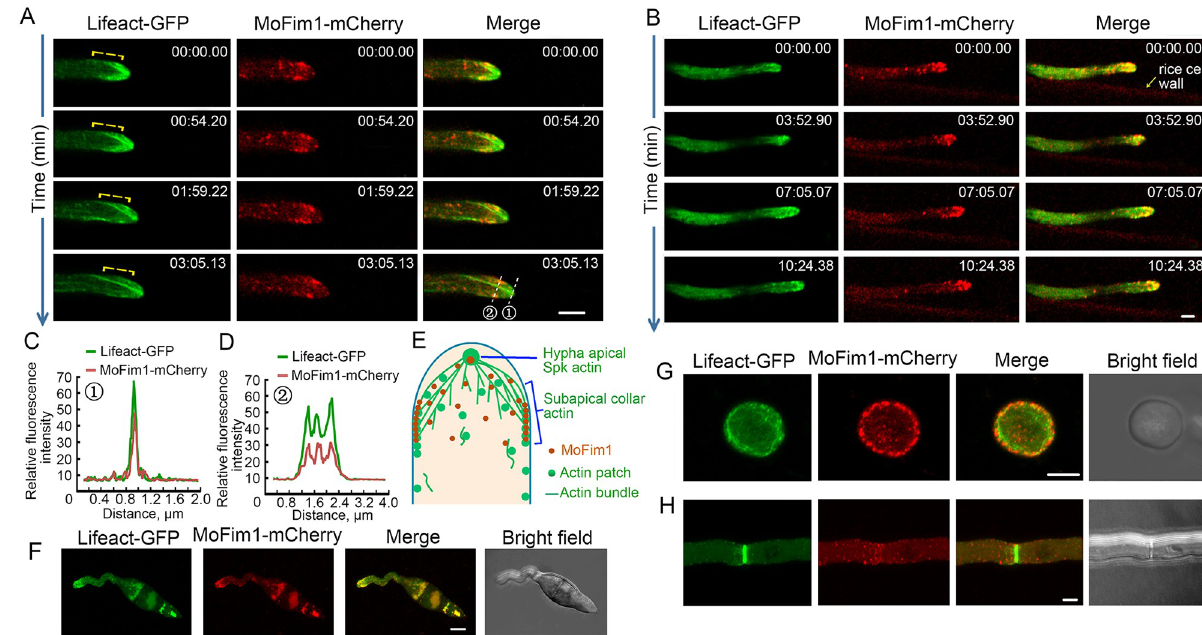
Fig 4. Localization of MoFim1 in M . oryzae . (A and B) Expression of p MoFim1 - MoFim1-mCherry in Lifeact-GFP-labeled Mofim1 mutant vegetative (A) and invasive (B) hyphae. The numbers at the top right corner indicate the timestamps (min:s). The yellow brackets indicate the subapical collar region. Bars = 2 μ m. (C and D) Line-scan analysis of the localization of MoFim1 related to the actin cytoskeleton. (E) Localization of MoFim1 in the hyphal tip. (F–H) Localization of MoFim1 in the M . oryzae germ tube (F) , appressorium (G) , and septum (H) . Bars = 5 μ m.